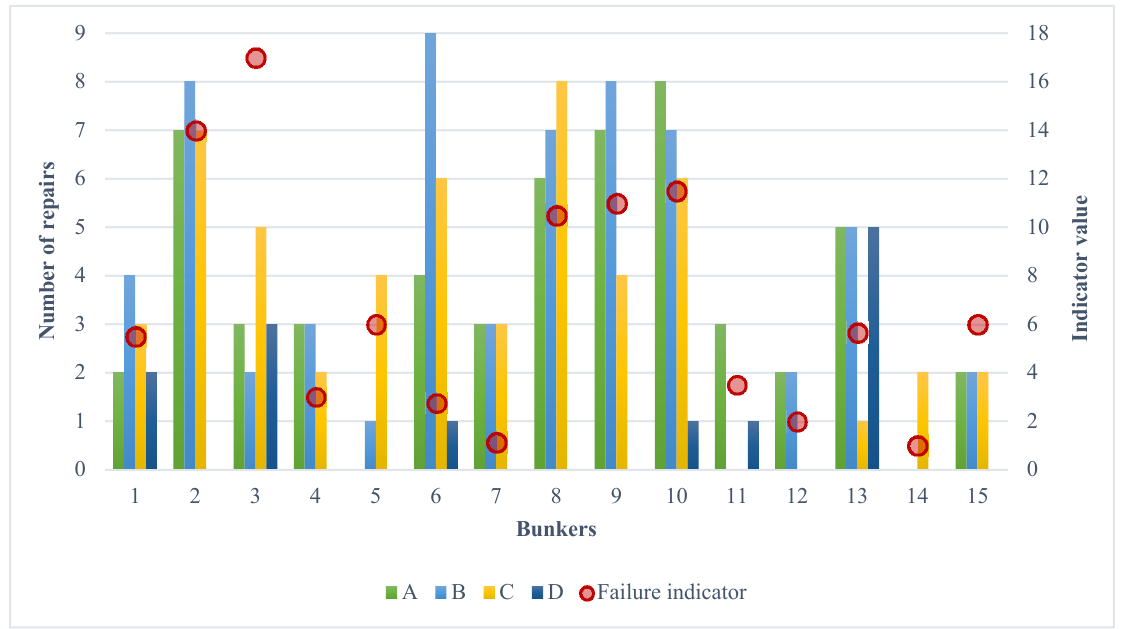
Figure 12. Number of repairs for the elements A, B, C, and D, and the daily failure indicator for the 15 receiving bins.